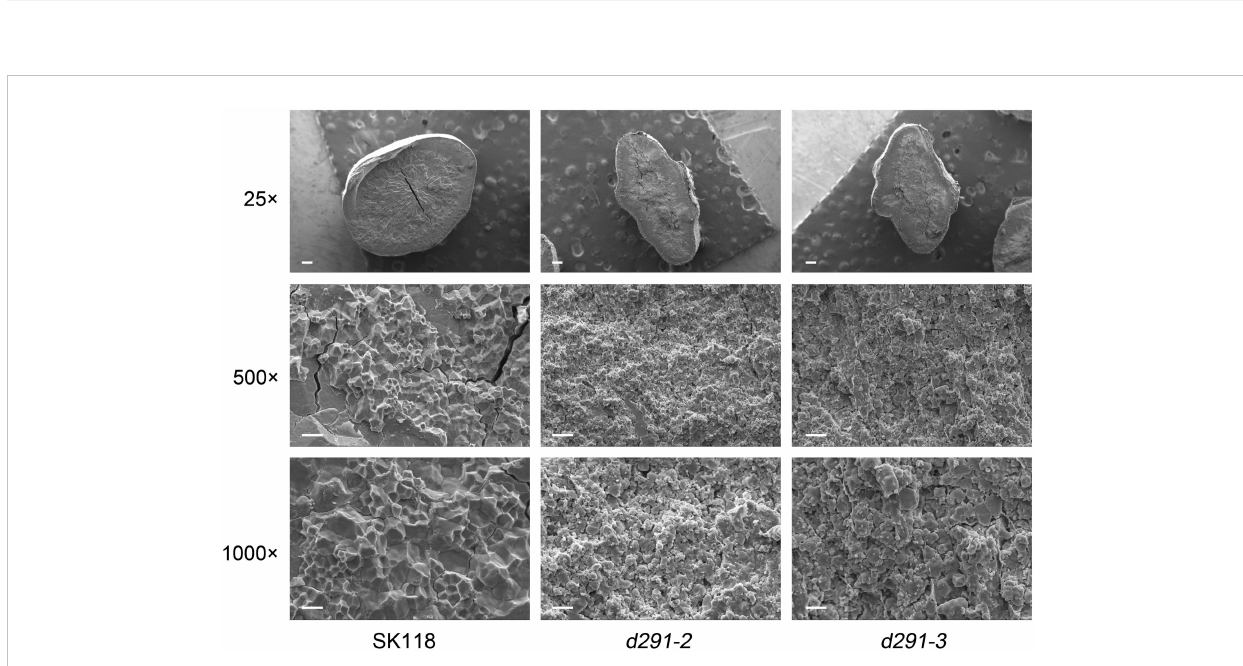
FIGURE 6 Morphology of starch granules in endosperm cells of fl o2 mutants. (A) Scanning electron microscopy images of the transverse section of fl o2 mutants and wild-type. 25×, Bars = 200 m m. 500×, Bars = 20 m m. 1000×, Bars = 10 m